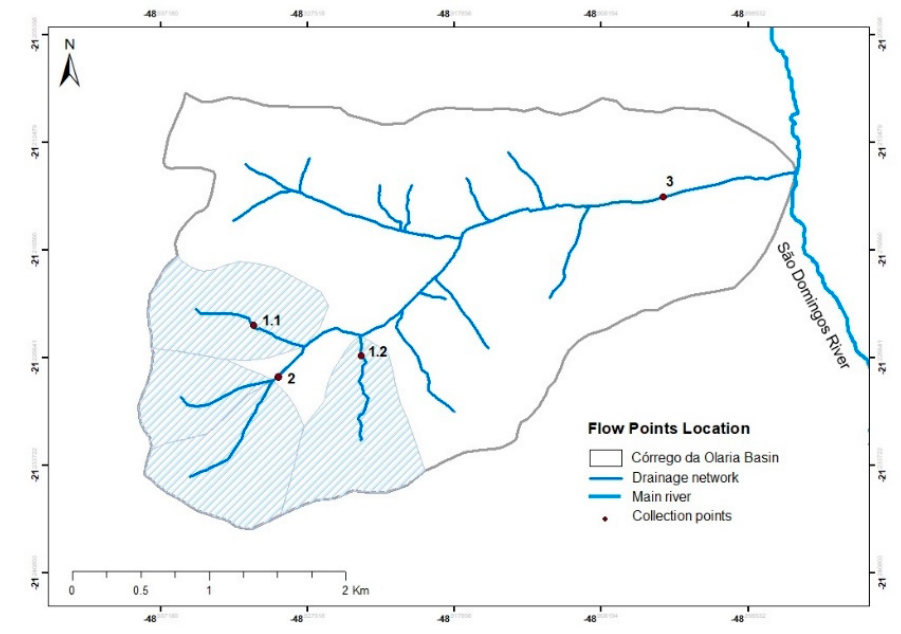
Figure 3. Drainage network of Olaria stream watershed, with identification of monitored sub-basins (1.1; 1.2; 2; 3).